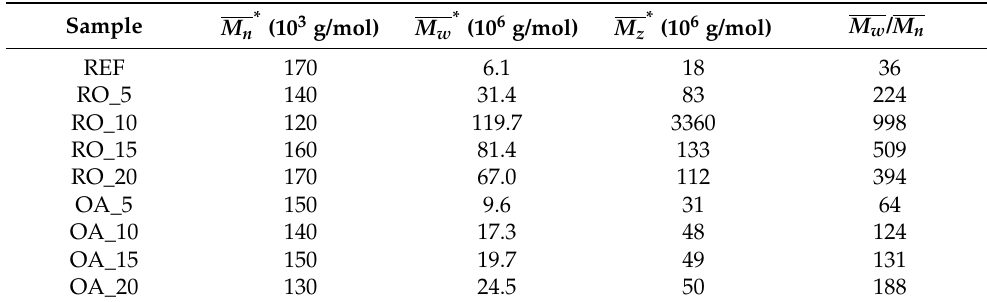
Table 5. Molar mass averages and dispersity of latex copolymers modified by AME_RO and AME_OA. Results are averages from three measurements. Sample